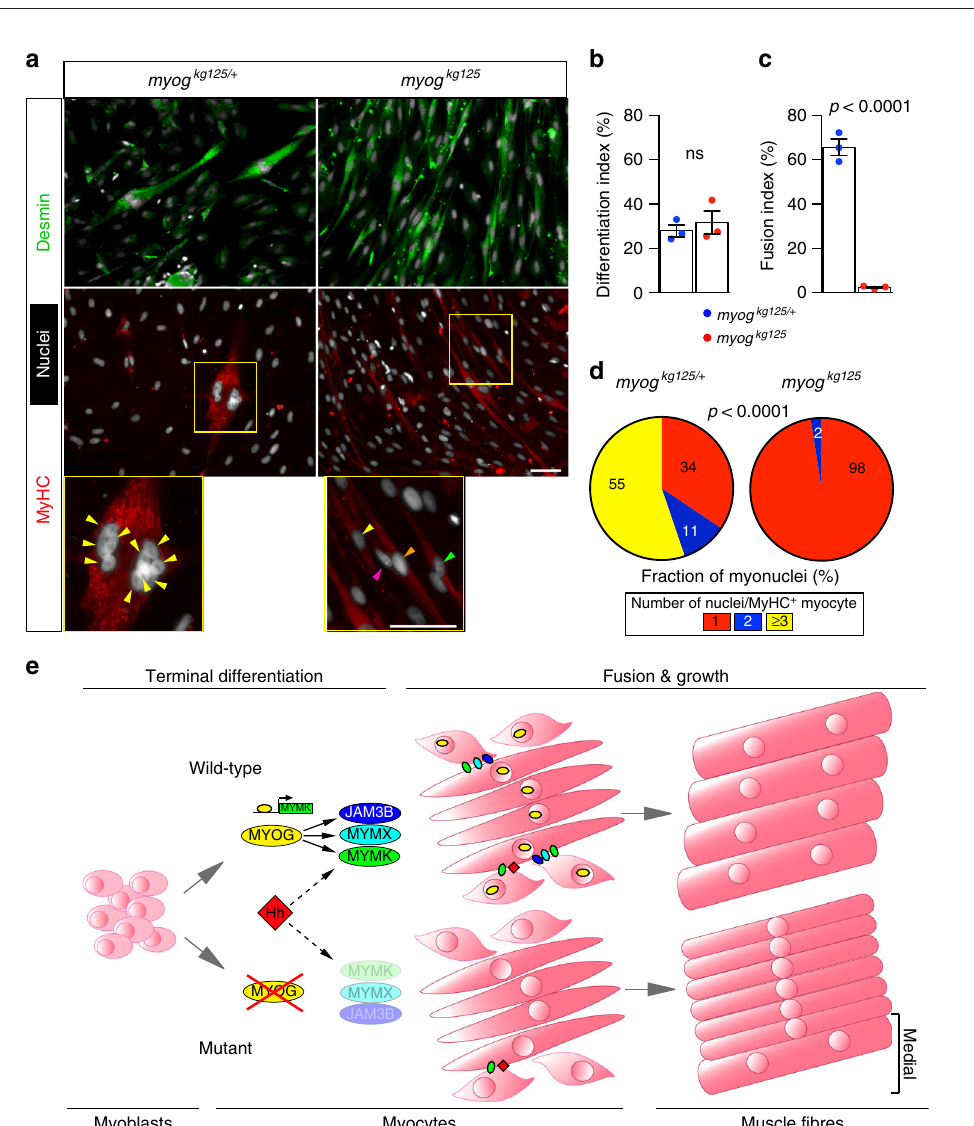
Fig. 7 Adult Myogenin mutants have reduced muscle with more but smaller myo fi bres. a Myog mutant and sib at 120 dpf from myog kg128/ + incross. Bar = 1 cm. Representative images n = 5 mutants, n = 23 sibs. b Myog kg128 or myog kg125 but not myog f fh265 showed reduced standard weight compared to co- reared sibs at 120 dpf. Dots represent individuals. c Laminin immunodetection on cryosections from 120 dpf myog 128/ + incross. Bar = 100 µ m. Representative images, n = 3. d – f Number of muscle fi bres in 0.1 mm 2 of adult muscle is increased in mutants ( d ), whereas myo fi bre cross-sectional area (CSA) is decreased ( e ) re fl ecting a shift in CSA frequency distribution compared to sibs. g Fewer myonuclear pro fi les were present within laminin pro fi les in adult muscle cross-sections in mutants than in sibs, measured from 107 to 490 fi bres at similar medio-lateral and dorso-ventral positions of trunk muscle of three fi sh per genotype. Mean ± SEM, t test. h Proportions of muscle fi bres with indicated number of myonuclei within fi bre cross-sectional pro fi le. In sibs, >90% of fi bres have more than one nuclear pro fi le, compared with < 15% in mutants. Mean ± SEM, χ 2 test. i NADH tetrazolium reductase stain revealed that in both mutants and sibs three fi bre types are present: oxidative/slow (slow), intermediate (int) and glycolytic/fast (fast). Size of more glycolytic myo fi bres (yellow and green insets) is more reduced than oxidative fi bres (cyan). Assay was performed on three 120 dpf adult male length- matched fi sh of each genotype. Representative sib (blue) or mut (red) fi bres are highlighted. Mutant presents smaller slow type myo fi bres ectopically localised in fast domain (red inset). Representative images, n = 3. Bars = 100 μ m (except for red, yellow and cyan insets = 10 μ